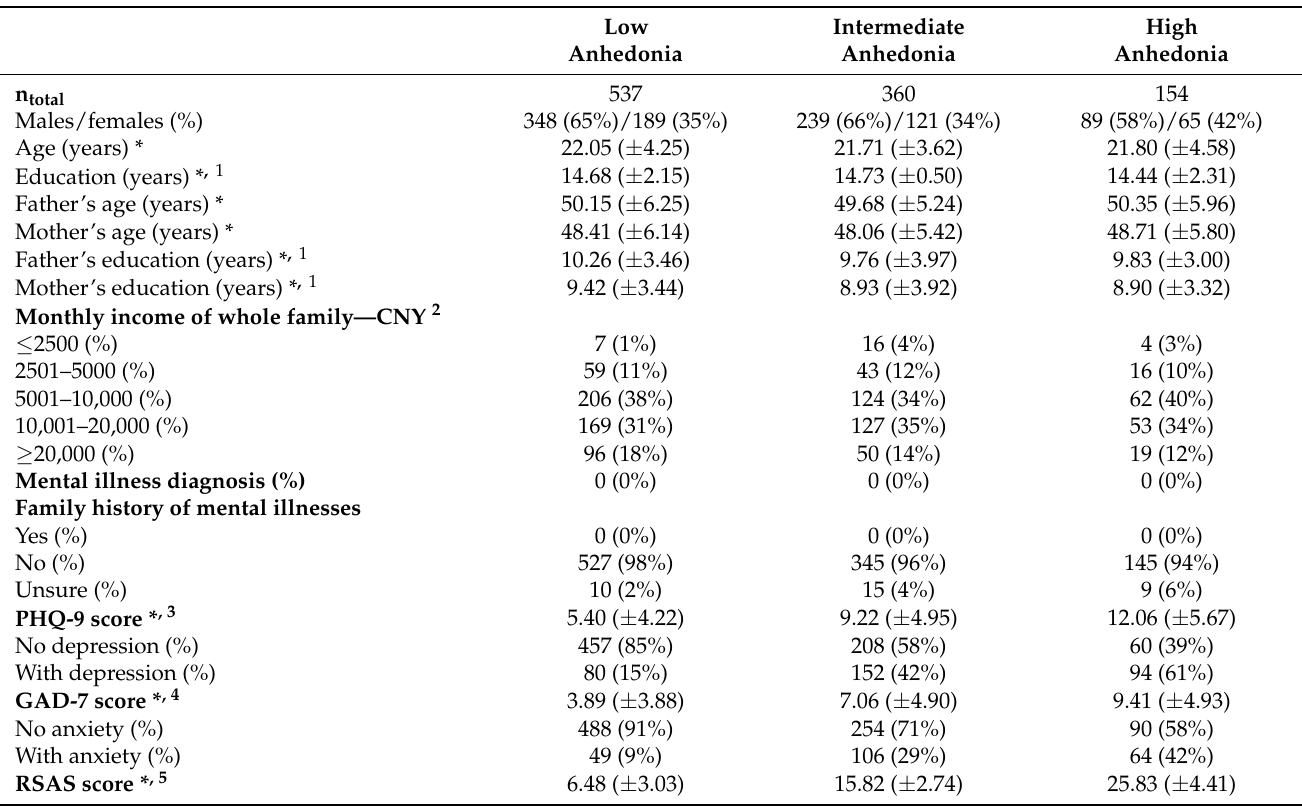
Table 2. Characterization of the three (an)hedonia